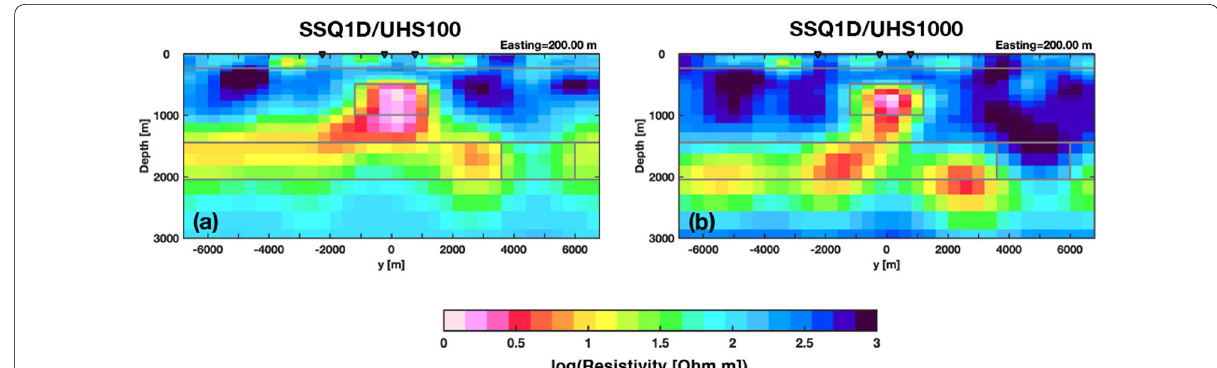
Fig. 28 NS cross sections at the easting of 200 m of the models inverted from the synthetic model (Fig. 1) with near‑surface distorters (Fig. 20). All used SSQ1D as the initial model, but the prior models, a UHS100 and b UHS1000, were examined. The result of SSQ1D/UHS10 is not shown, as its inversion did not converge